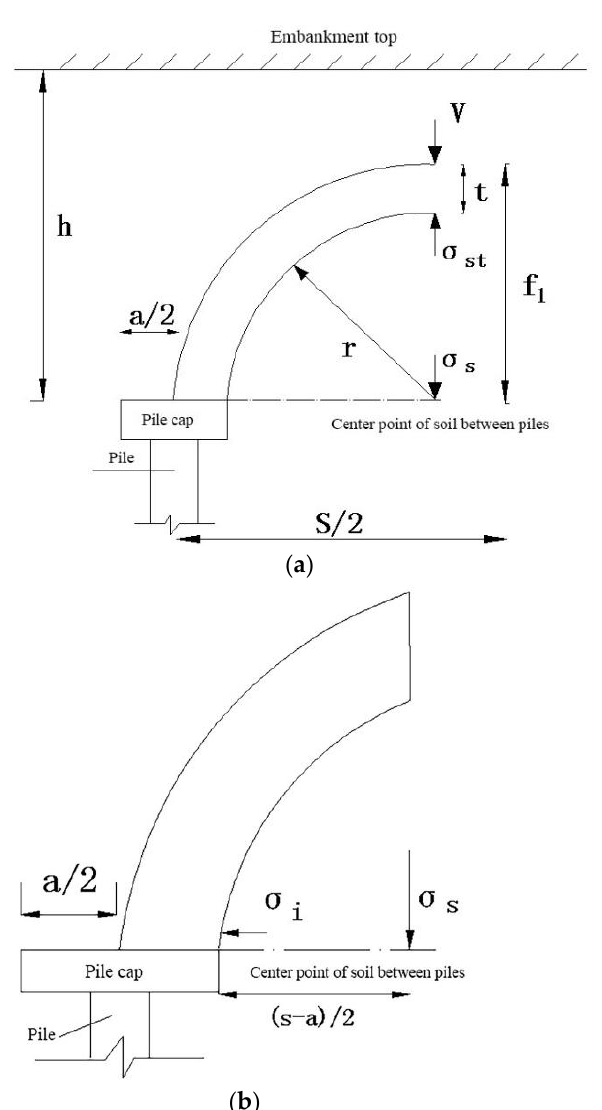
Figure 2. Integral calculation diagram of earth pressure on top of pile cap: ( a ) inside primary arch vault; ( b ) inside primary arch skewback.